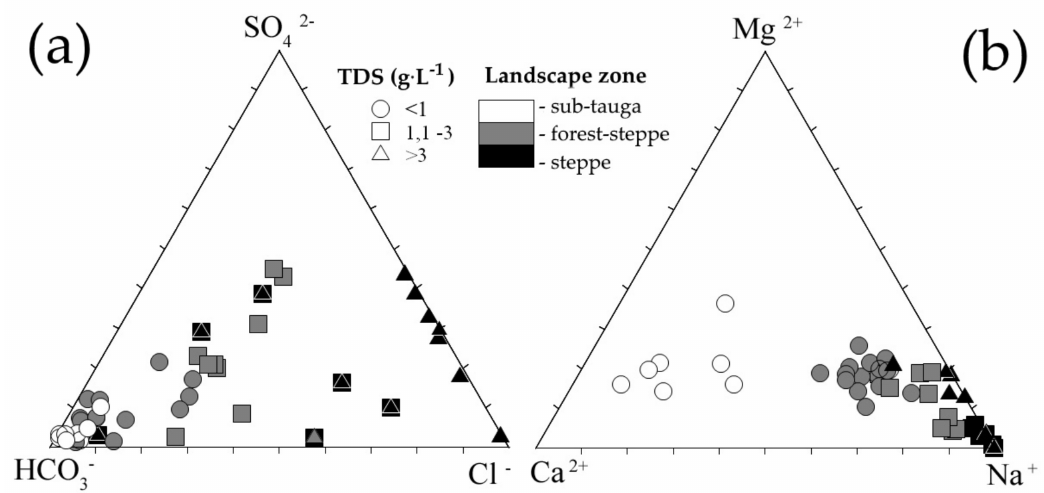
Figure 3. Ferre Triangle of lake water composition, taking into account the total dissolved solids’ (TDS) values and landscape type. ( a ) anionic composition of water, ( b ) cationic composition of